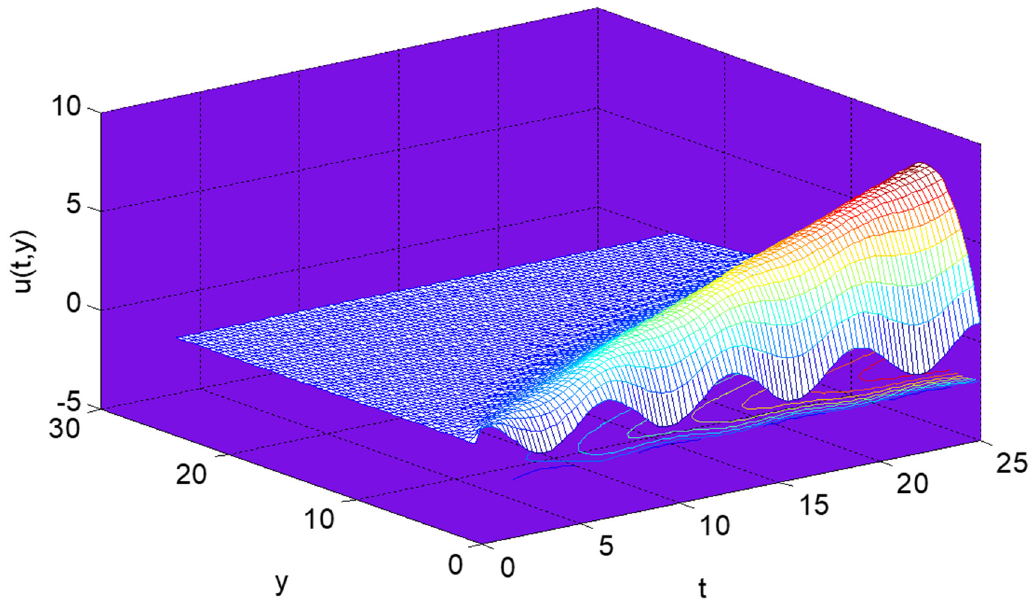
Figure 10. Surface plot with underneath contours for velocity profile of Stokes’ second problem in Quantum Calculus by the proposed scheme for spatial direction and Crank–Nicolson scheme for time direction using N y = 50, N t = 100, q = 0.8, λ = 0.9, β = 0.9, Pr = 0.7.